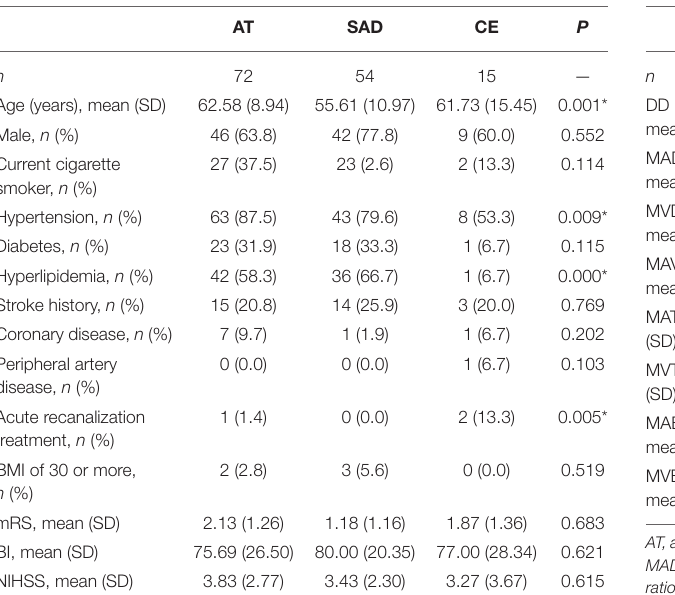
TABLE 1 | Comparison of demographic and clinic characteristics among AT, SAD, and CE subtypes. AT SAD